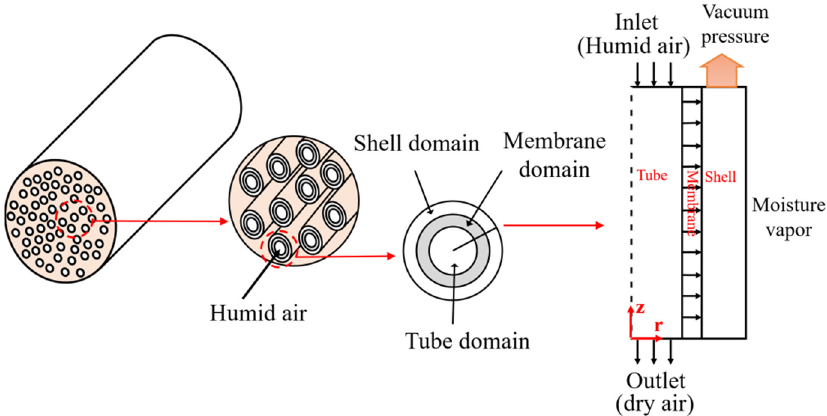
Figure 2. Schematic of a hollow fiber membrane module and the three domains of a hollow fiber 167 membrane. 168